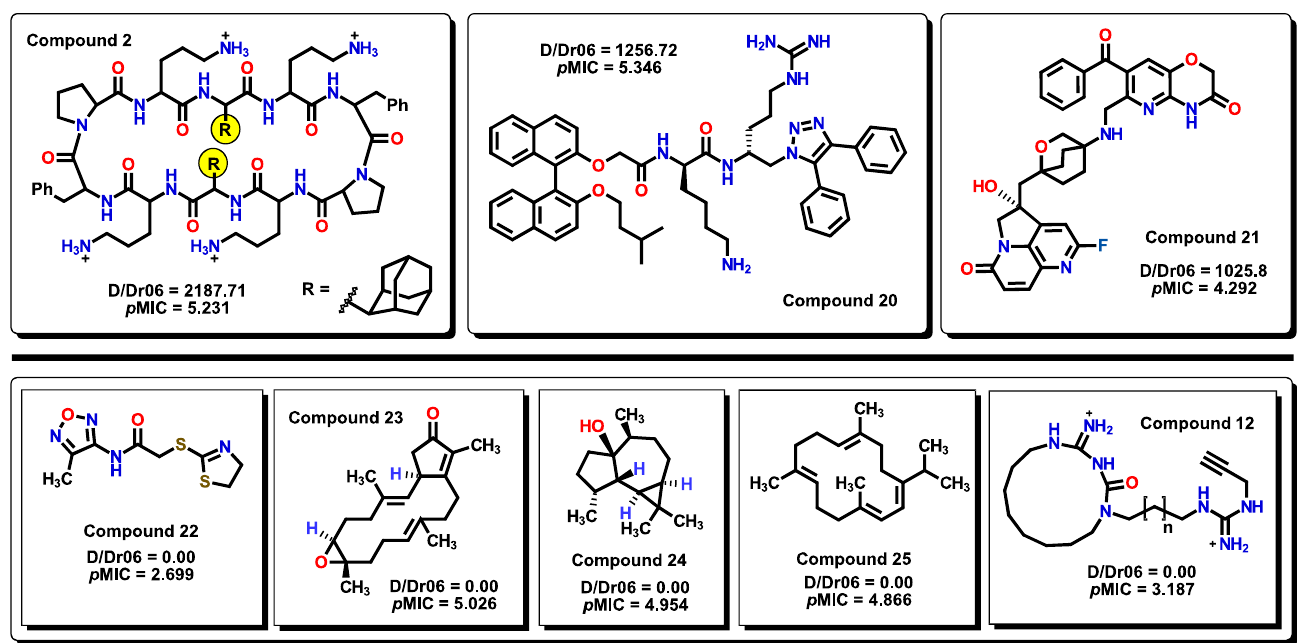
Figure 7. On the top row, the highest D/Dr06 values are displayed for compounds. Below, molecules that do not have any 6-membered rings in their structures display a zero value of the descriptor. The second Mohar index [60] (TI2) is calculated from the eigenvalues of the Laplacian matrix as shown: